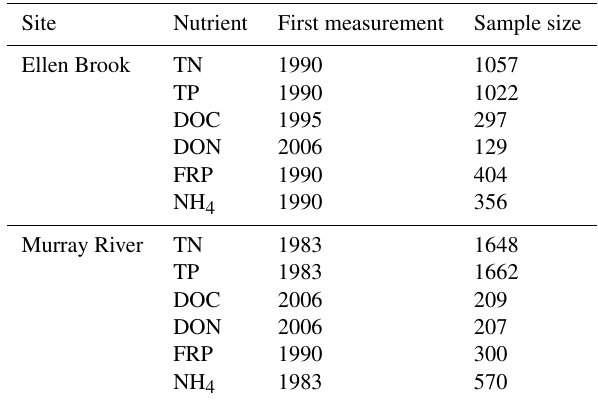
Table 3. Nutrient sampling time and sample size in Ellen Brook and Murray